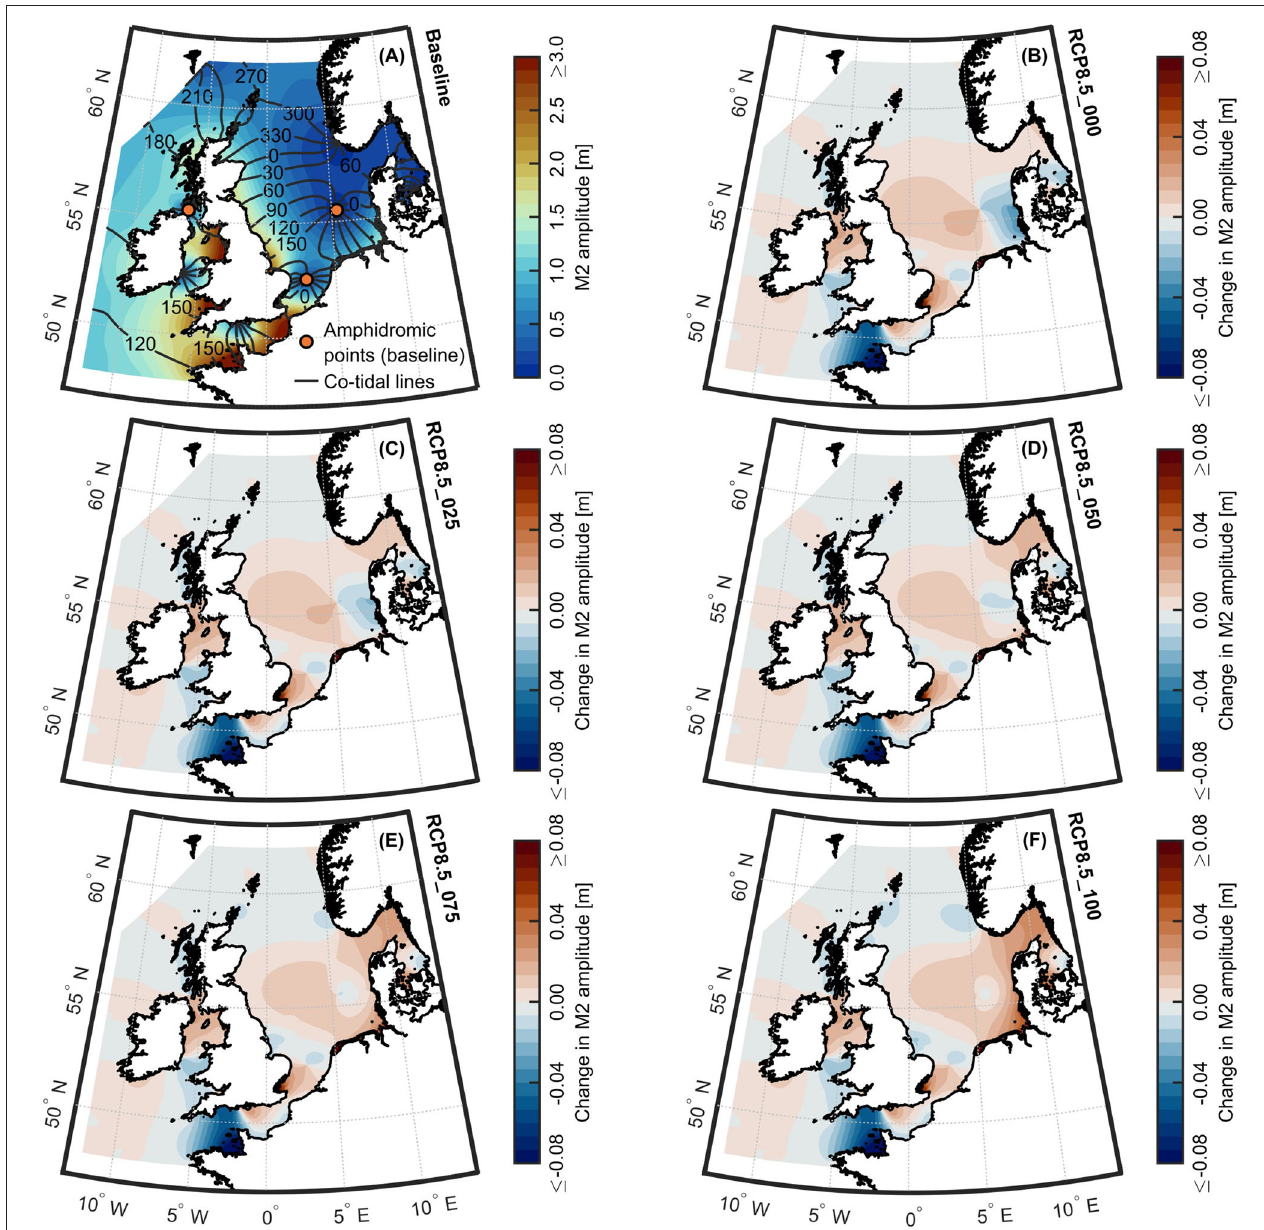
FIGURE 6 | M2 amplitudes for the NWES resulting from the combinations of 0.8m SLR projection and various cumulative rates of vertical accretion. (A) Map of M2 amplitudes for the NWES for the baseline scenario, according to the 3-month period from September 1 to December 1, 2012. Relative changes in M2 amplitudes for scenarios (B) RCP8.5_000, (C) RCP8.5_025, (D) RCP8.5_050, (E) RCP8.5_075, and (F) RCP8.5_100.